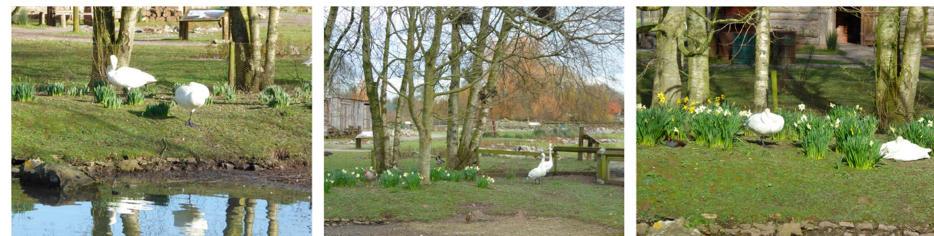
Figure 3. Photos of the whistling swans from the three observations (left to right: Obs 1 – 3) in Table